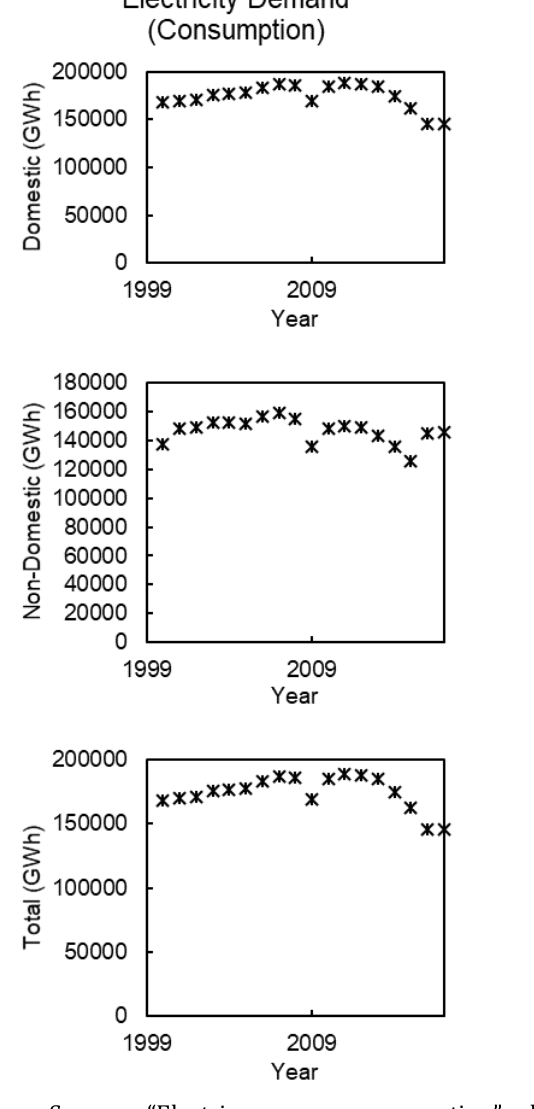
Figure 1: Dynamics of explanatory variables changes and changes in electricity